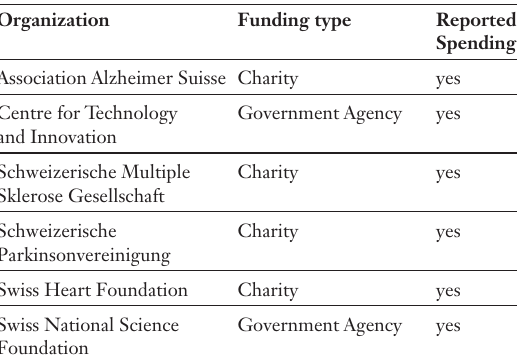
Total funding of brain research by disorder in Europe